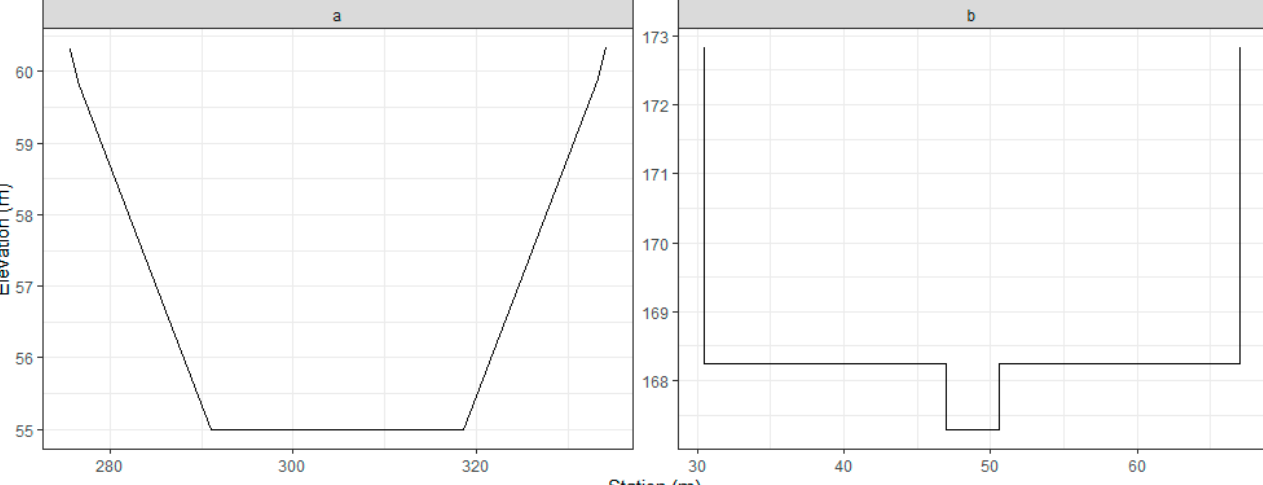
Figure 3. Map of the Los Angeles River watershed and extent of the HEC-RAS model.